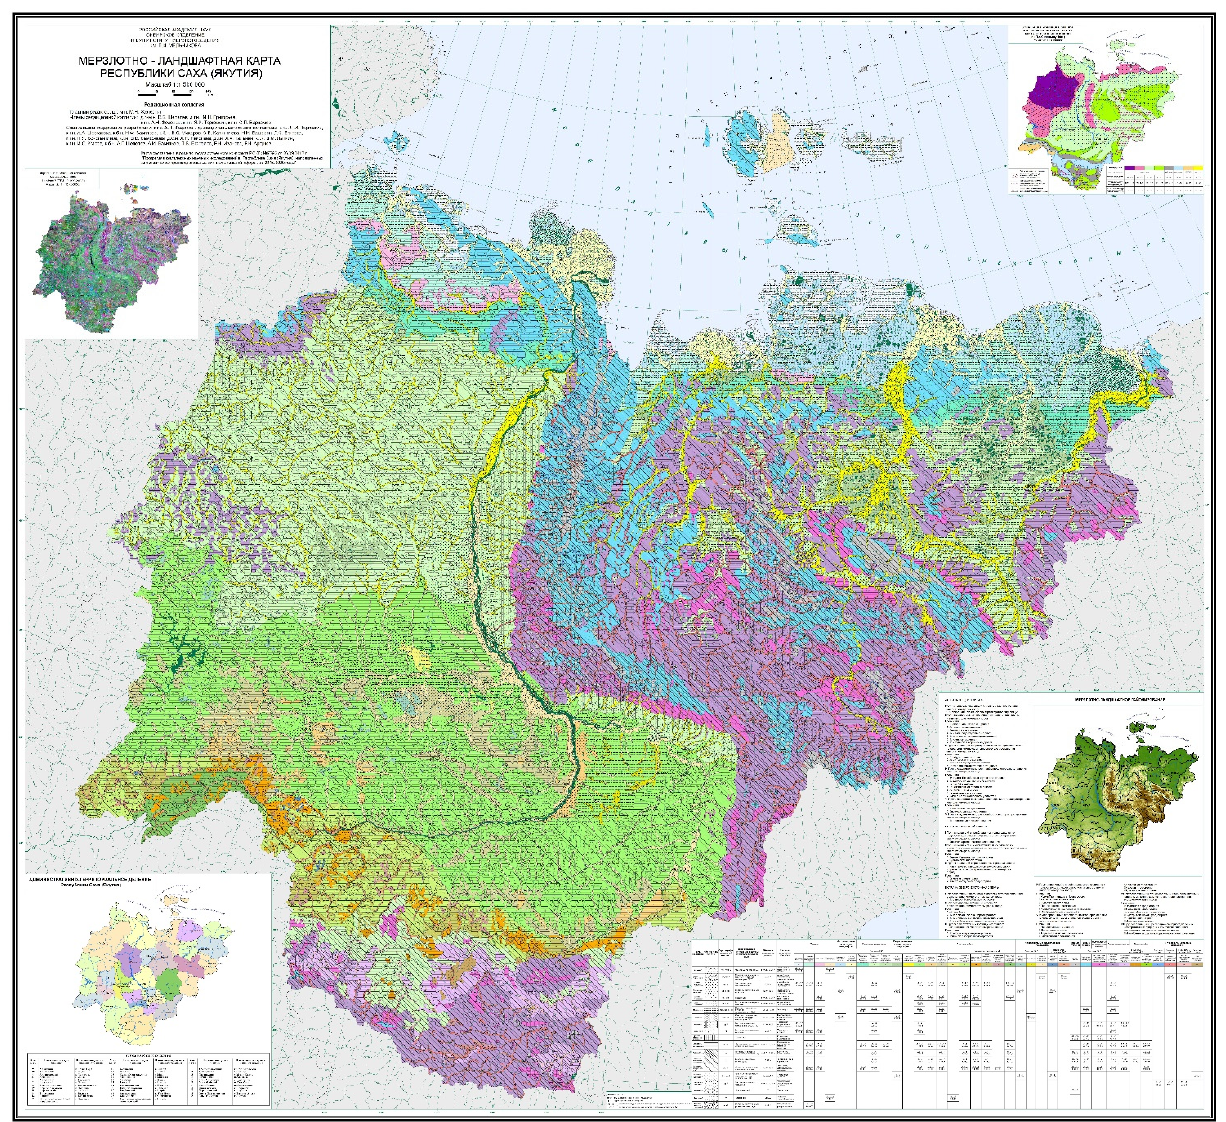
Figure 1. Permafrost landscape map of the Republic of Sakha (Yakutia) on a scale of 1:1,500,000 [105].